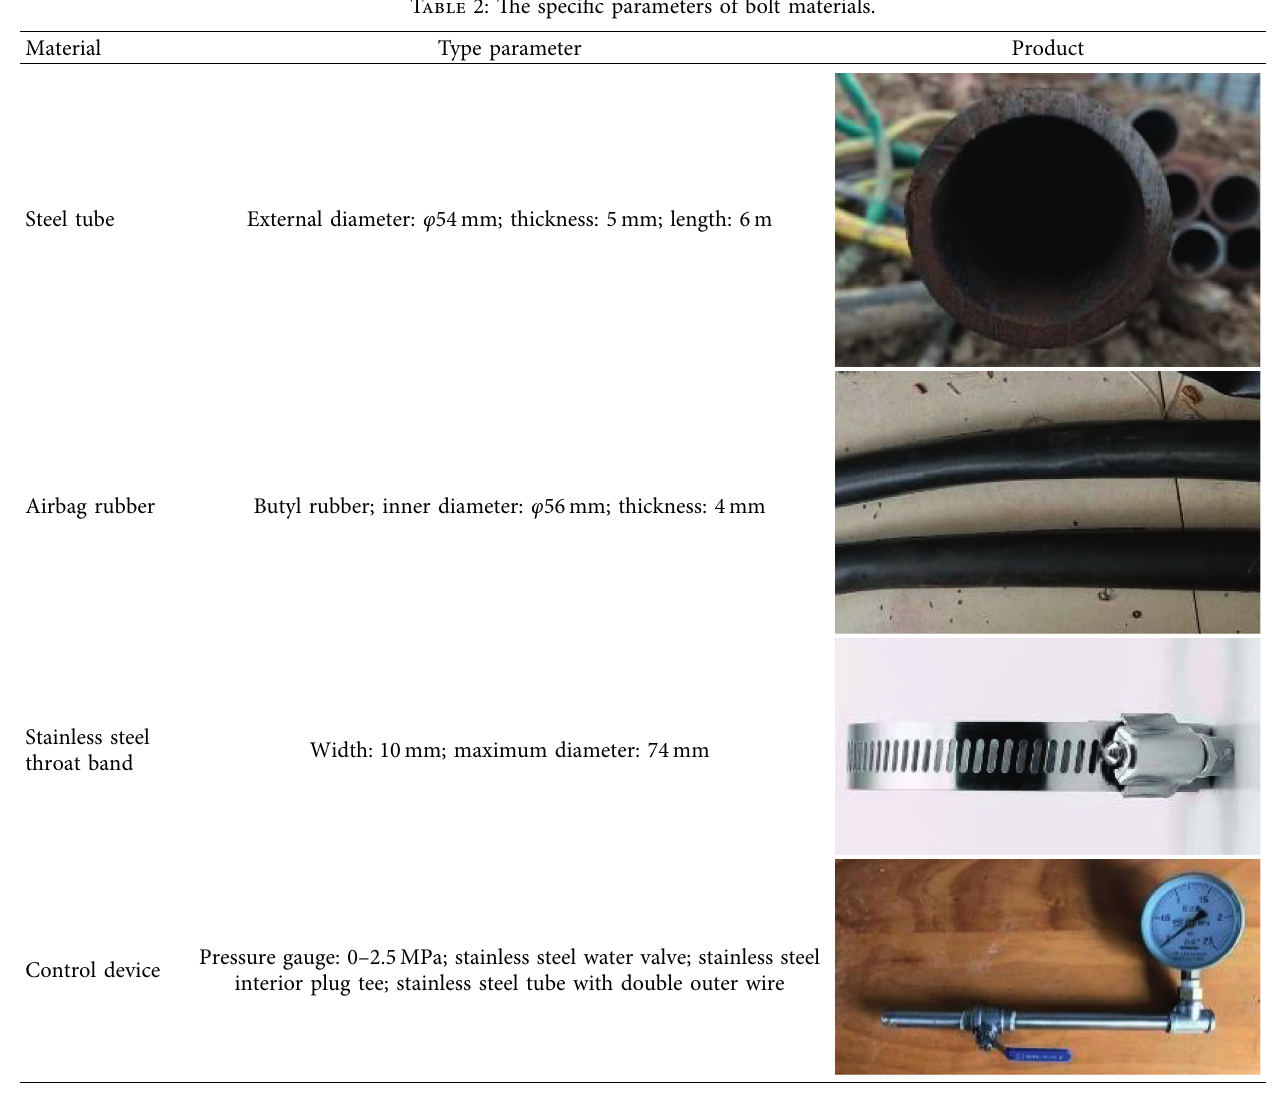
Table 2: The specific parameters of bolt